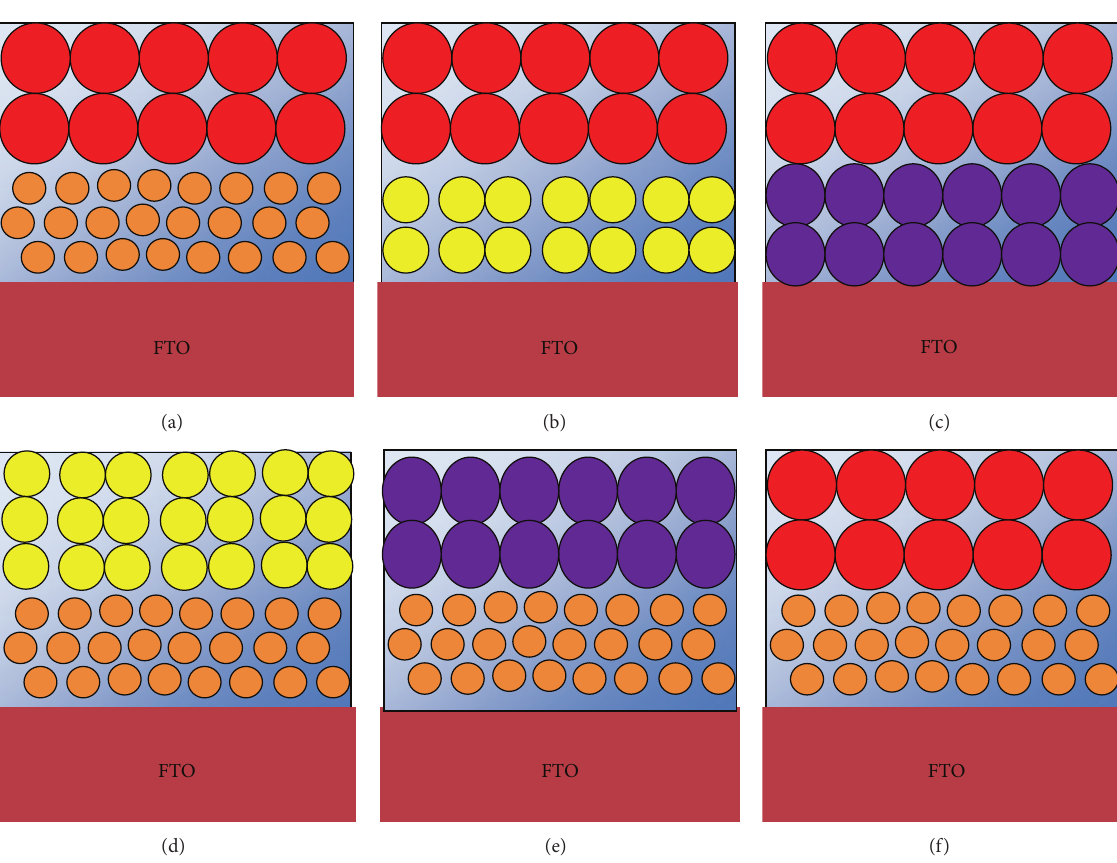
Figure 3: The schematic diagrams of double-layer structures with the different particle sizes in the top and bottom layers.